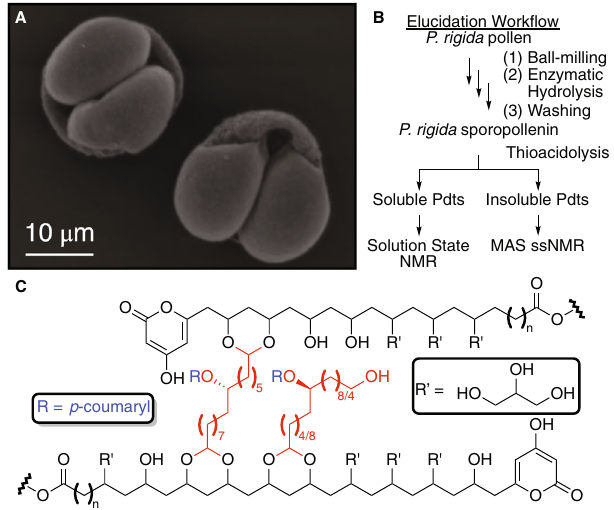
Fig. 1 Summary of the current structural model of pine sporopollenin. A Electron micrograph of P. rigida pollen 35 , B work fl ow employed in the structural elucidation of P. rigida sporopollenin, and C previously proposed 13 C MAS ssNMR averaged structure of P. rigida sporopollenin (structural notes: pyrone may be substituted by an ester moiety, approximately 15% of aliphatic units are singly crosslinked, higher dimensional crosslinking is likely, the linkage between R ’ and the backbone is currently unknown and has been purposefully left ambiguous herein) 35